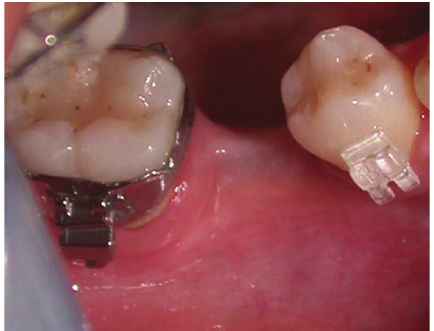
Figure 5: Site of 4.6.